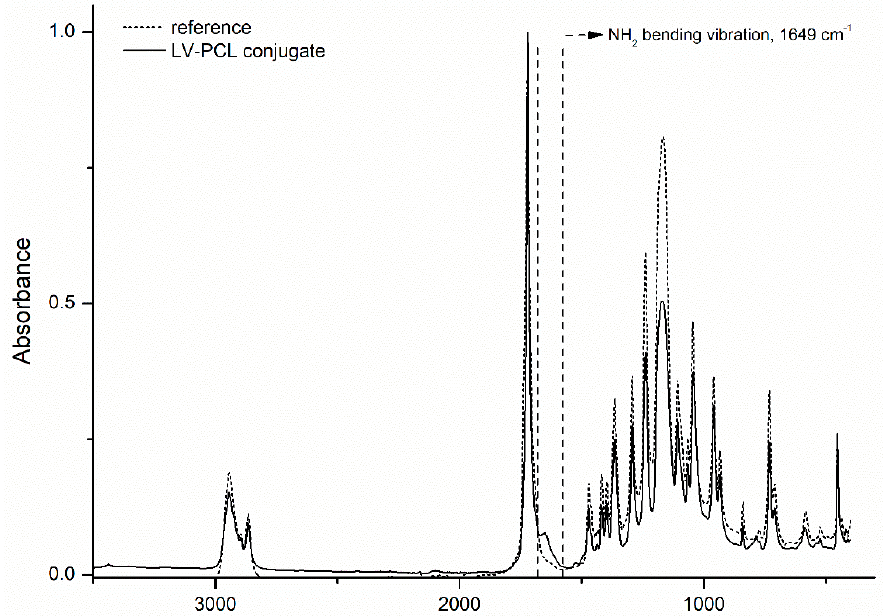
Figure 5. IR spectra of and polymer-drug conjugate and non-conjugated poly- ε -caprolactone reference.